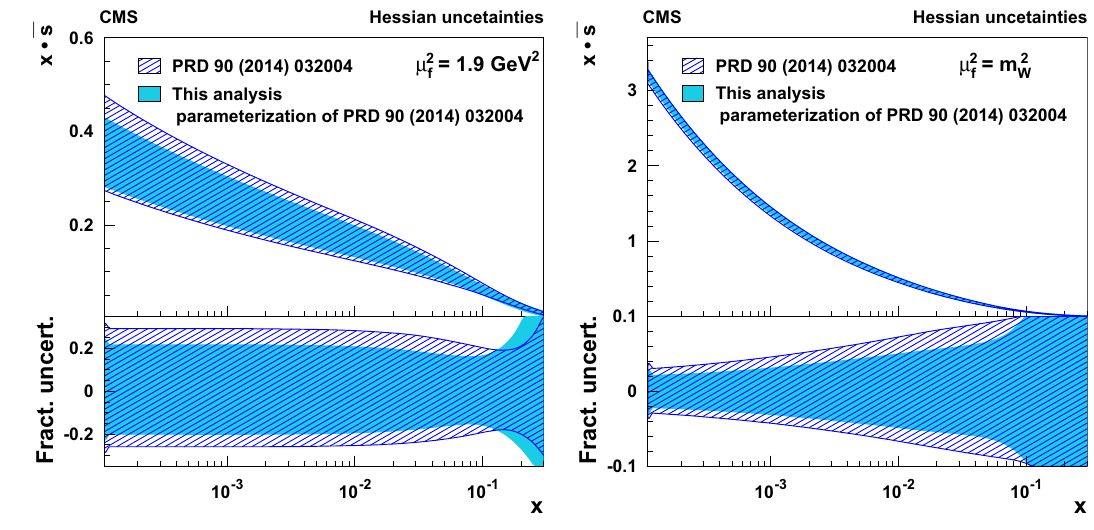
Fig. 7 The strangeness suppression factor as a function of x at the factorization scale of 1.9GeV 2 (left) and m 2 analysis (hatched band) are compared to ABMP16nlo (dark shaded band) and ATLASepWZ16nnlo (light shaded band) PDFs